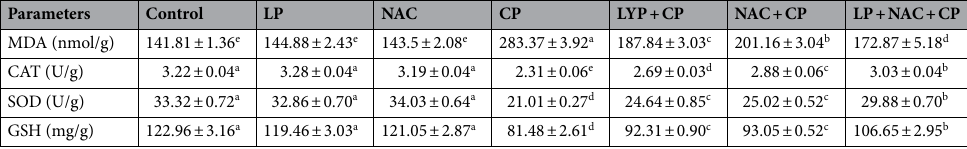
Table 2. Effects of LP, NAC, and/or CP on antioxidant parameters in hepatic tissues (n = 7). Data are expressed as the mean ± SE (n = 7). Different superscript letters in the same row indicate statistical significance at P ≤ 0.05. Cisplatin (CP) at a single dose of 7.5 mg/kg (IP); Lycopene (LP) at dose of 10 mg/kg; N-acetycysteine (NAC) at a dose of 150 mg/kg. Malondialdehyde (MDA); catalase (CAT); superoxide dismutase (SOD); reduced glutathione (GSH).